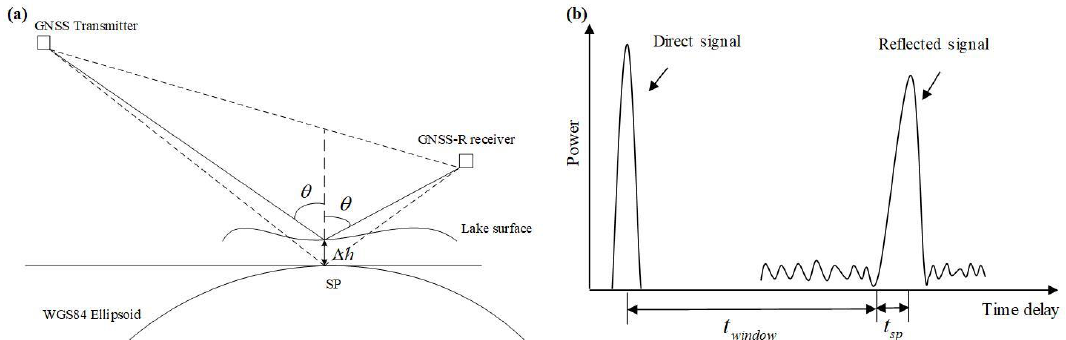
Figure 2. Principle of lake water level measurement using TechDemoSat-1 (TDS-1) data. ( a ) Geometry of lake water level measurement. The solid reflected line minus the direct path is τ obs , and the dotted reflected line minus the direct path is τ ref ; ( b ) calculation of the observed time delay. τ window represents the delay of the delay-Doppler map (DDM) window and τ sp represents the delay of the specular point within the DDM window.